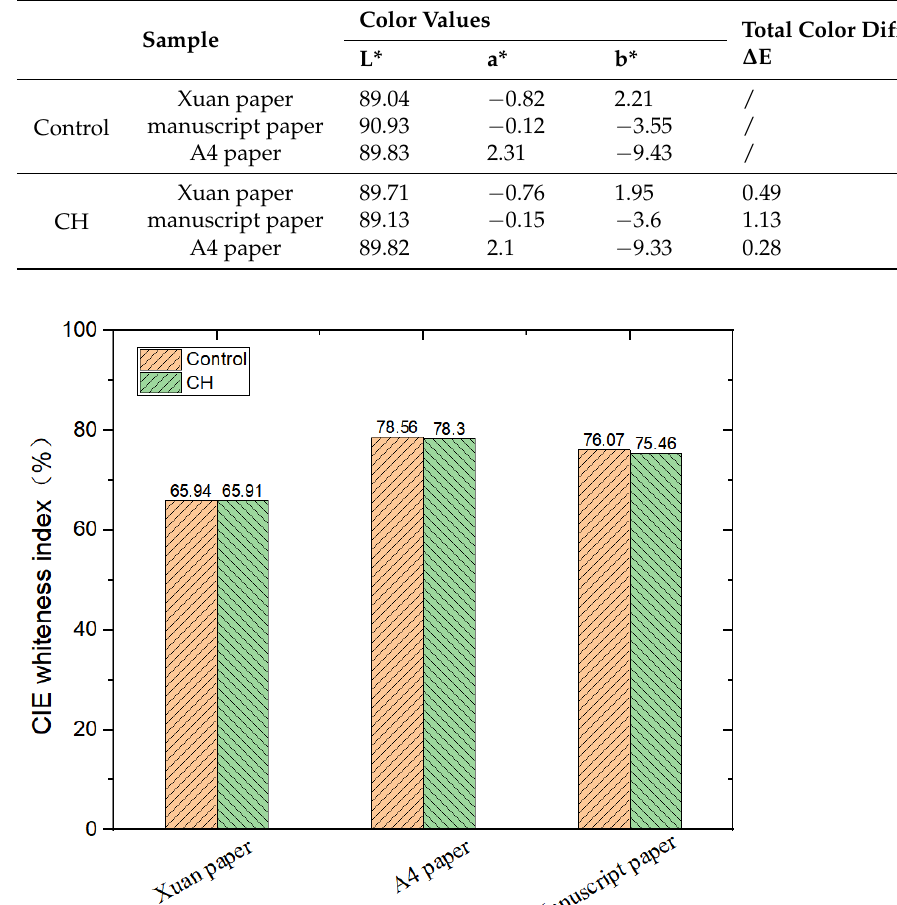
Figure 9. The CIE indexes of the different treated papers.